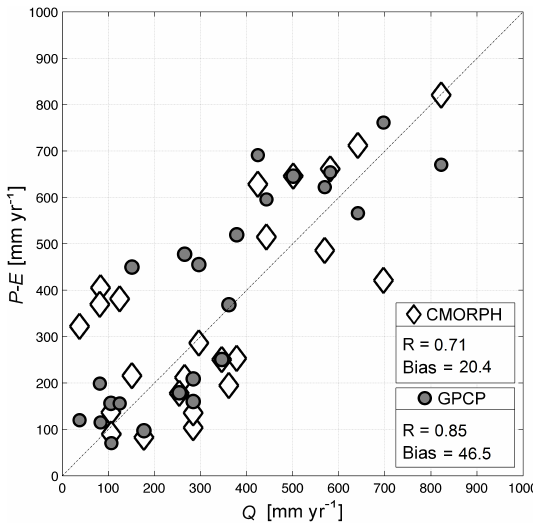
Fig. 2. GLEAM estimates of P − E are compared to the runoff ( Q ) from 24 different catchments for the period 2003–2006. Correlation coefficients ( R ) and mean bias errors (bias) are listed for both the validation exercise using GPCP and the one using CMORPH (gap- filled with GPCP as explained in Sect.